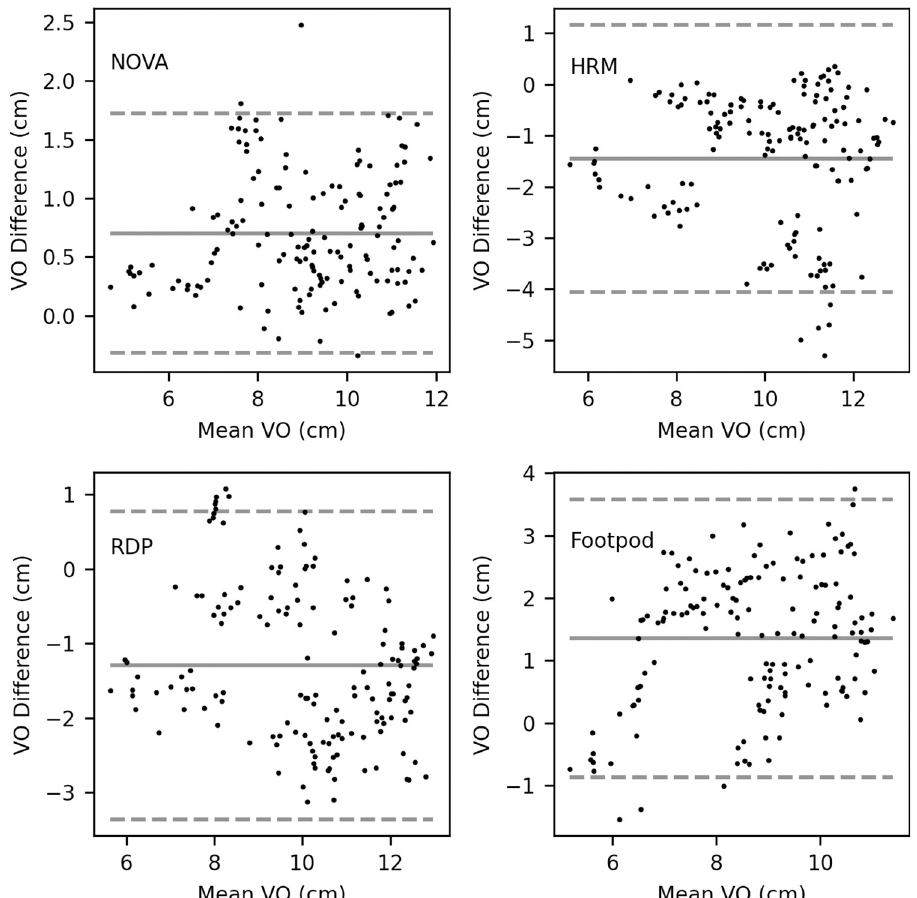
Fig 4. Bland-Altman plots between video analysis vertical oscillation and wearable devices. Bland-Altman plot for video analysis vertical oscillation values compared to INCUS NOVA (top left), Garmin HRM-Pro chest strap (HRM, top right), Garmin Running Dynamics Pod (RDP, bottom left), and Stryd Running Power Meter Footpod (Footpod, bottom right). Mean bias is indicated by the solid line. Dashed lines indicate 95% Limits of Agreement. All running intervals (n = 10) and participants (n = 15) were